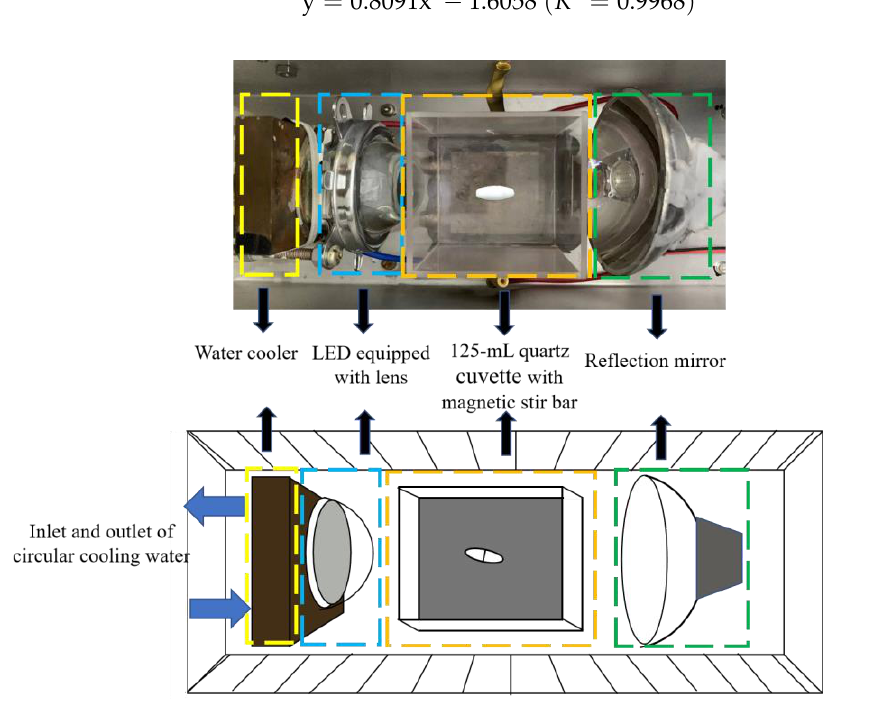
Figure 2. The assembly of the reactor for the photocatalytic degradation of RhB.